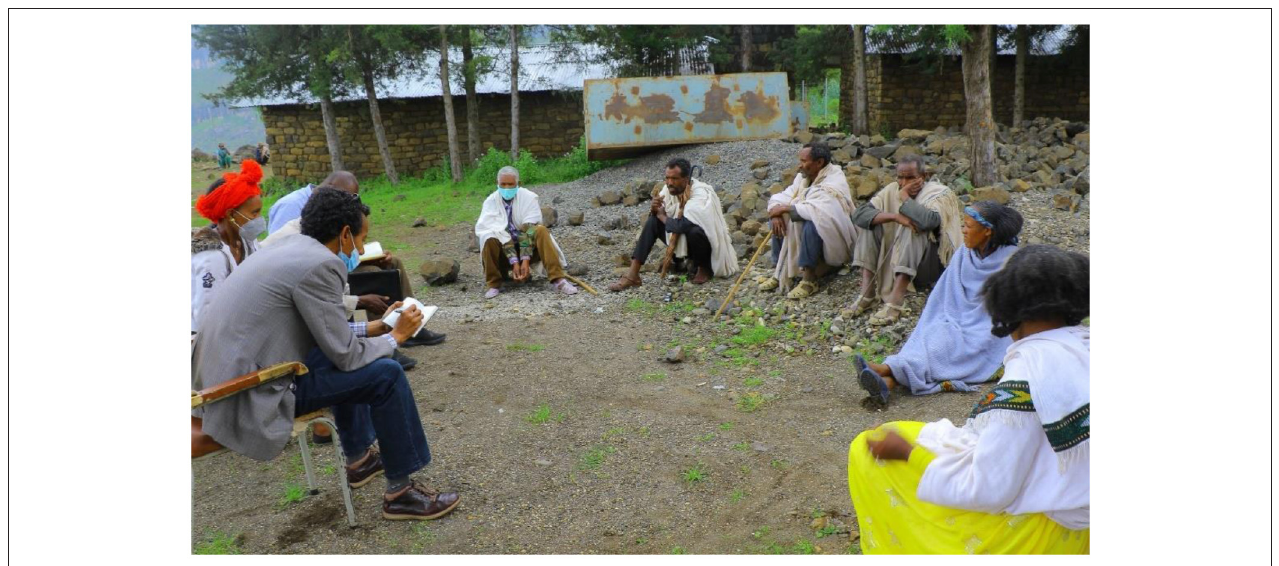
FIGURE 9 | ECLIPSE team members convening a CAG meeting in